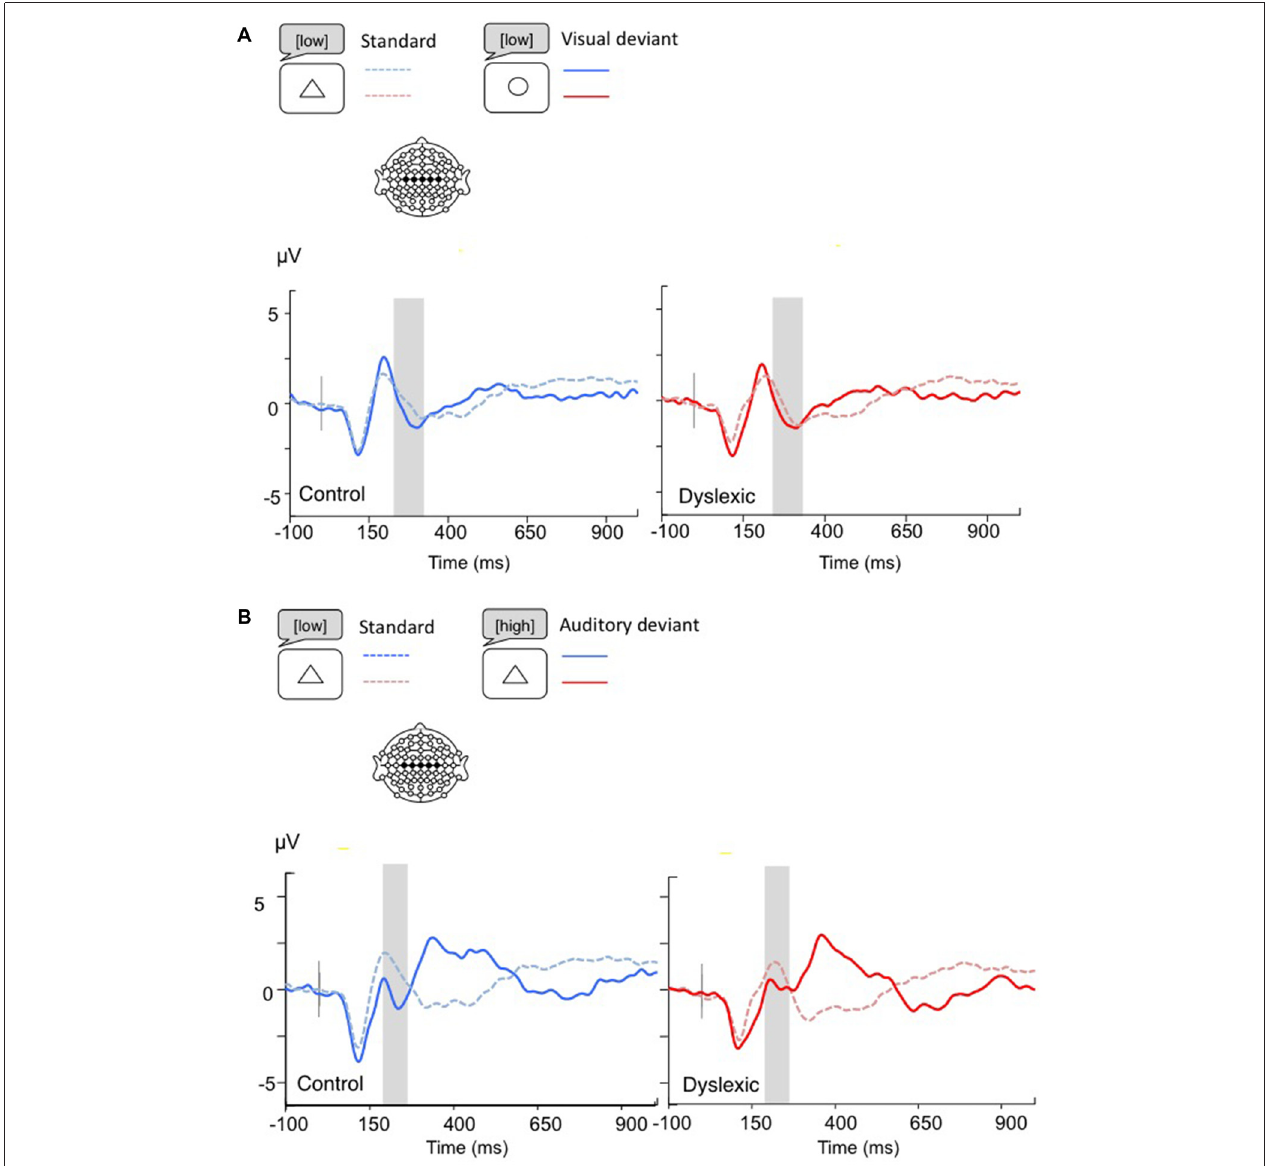
FIGURE 4 | Linear derivations over the electrodes where the MMN was maximal for typical and dyslexic readers’ responses in correct trials (Gray bar: analysis window). (A) Visual deviants; (B) Auditory